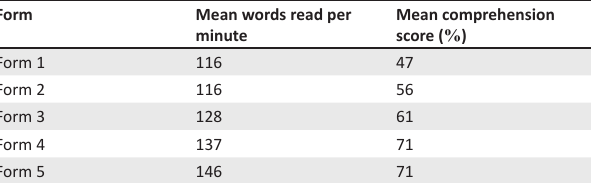
TABLE 2 : Results of the test of reading